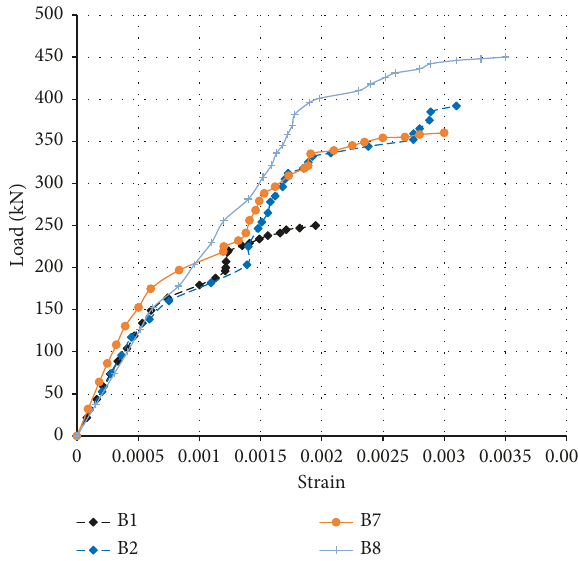
Figure 19: Load strain in concrete performances for models B1, B2, B7, and